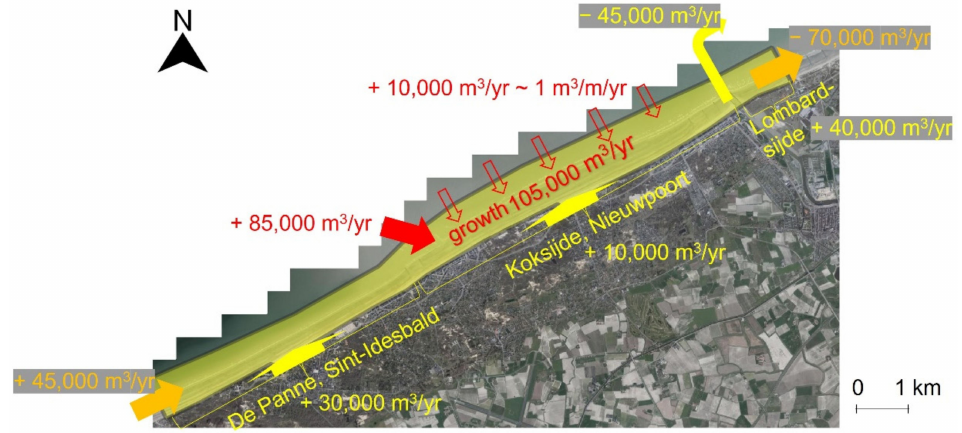
Figure 10. Conceptual model for the large-scale sand exchanges in the study